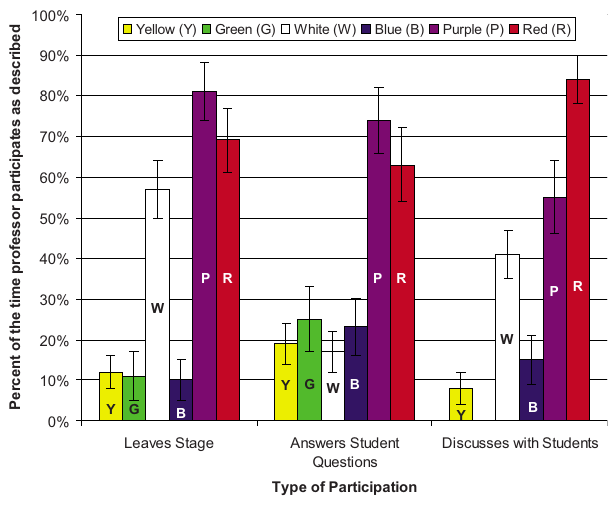
FIG. 1. (cid:1) Color (cid:2) The percentage of observed CQs where the pro- fessor was observed to participate with the students during the re- sponse time by leaving the stage (cid:1) column 1 (cid:2) , answering student questions (cid:1) column 2 (cid:2) , or actively discussing with the students (cid:1) col- umn 3 (cid:2) . The error bars shown are the standard error on the